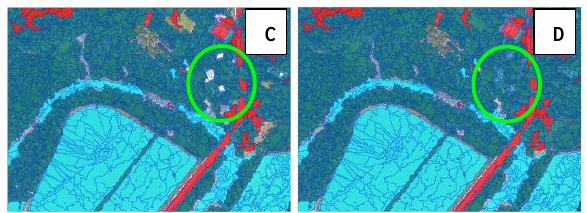
Figure 8. Vegetation classification using assign class algorithm with mean DSM minimum threshold value of 65.